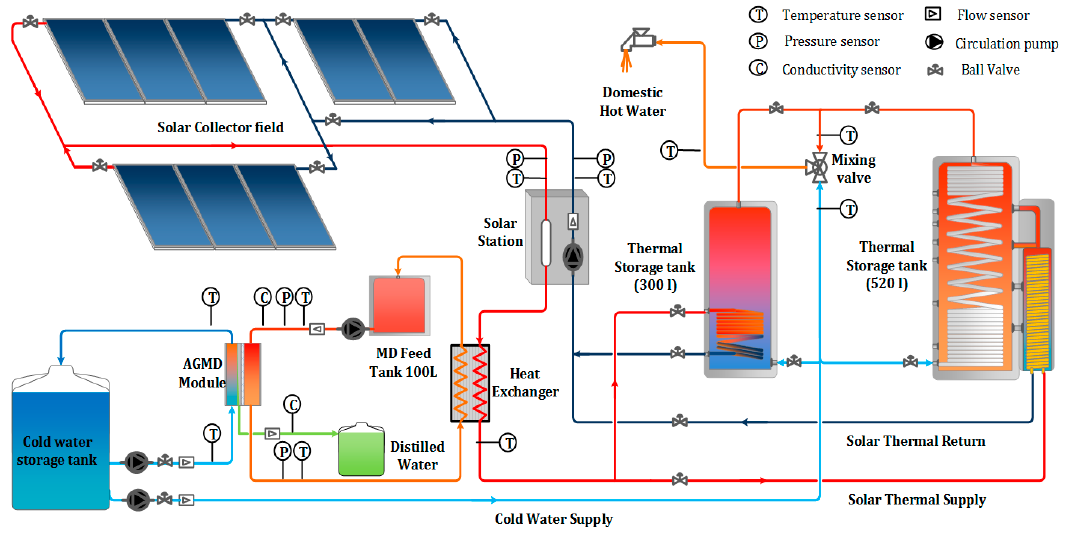
Figure 5. Schematic representation of direct solar combi MD system (SCMD).